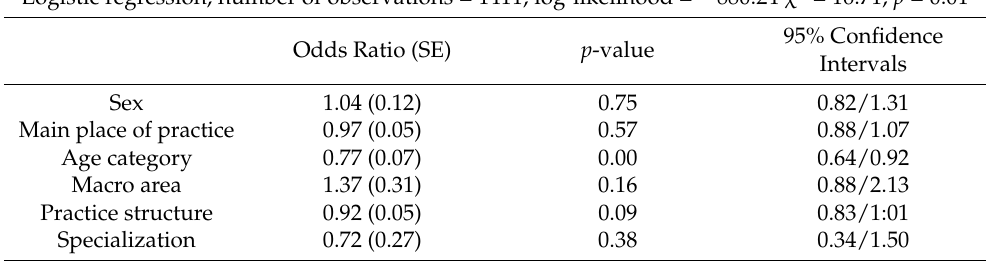
Table 3. Survey of the participants if they experience a collapse and/or quarantine measures due to a positive test/infection/disease of dental personnel. The respondents were stratified by sex, age, macro area, practice structure and which specialization the practice in which they work has. Did your practice experience a collapse and/or quarantine measures due to a positive test/infection/disease of dental